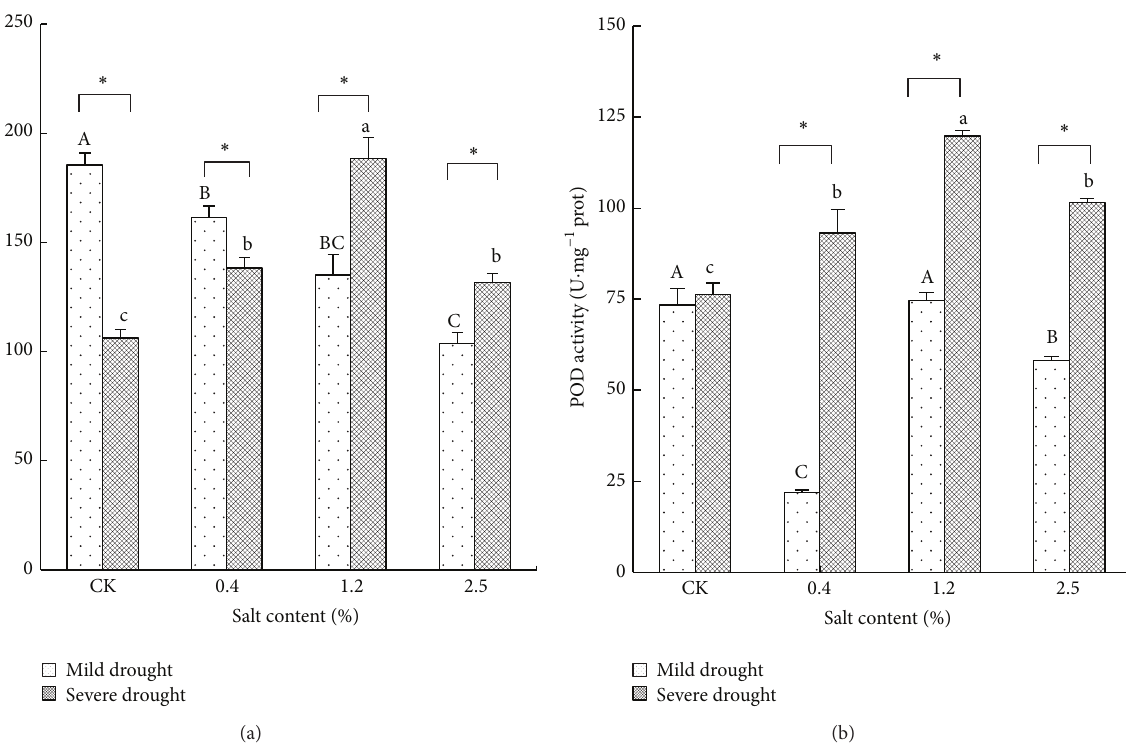
Figure 1: The changes of SOD and POD activity under different salt and drought stresses. The different letters within the same treatment indicate the significant difference at 0.05 level. The “ ∗ ” stands for the significant difference at 0.01 level between two treatments under the same salt stress.